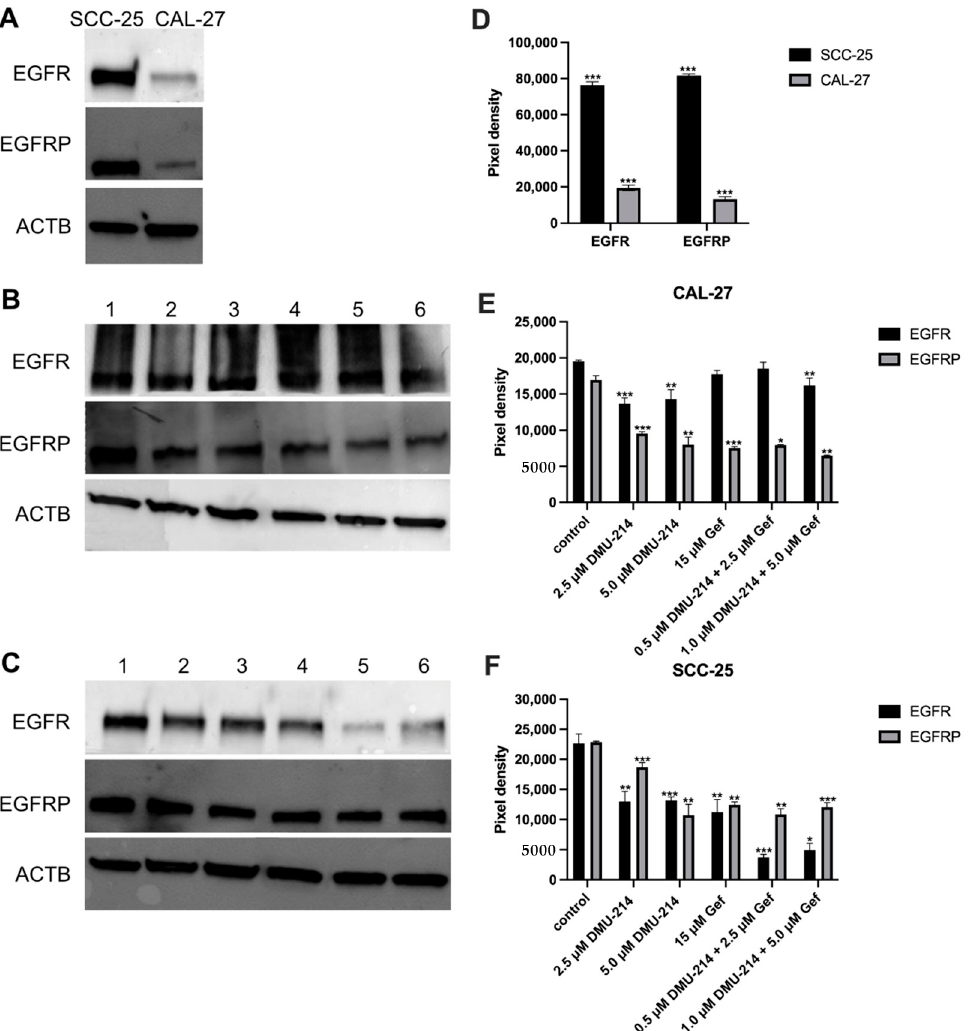
Figure 5. Western blot analysis of EGFR and EGFRP native expression pattern ( A ) as well as the effect of DMU-214, Gef, and the combination of DMU-214 and Gef on the EGFR and EGFRP ex- and the combination of DMU-214 and Gef on the EGFR and EGFRP expression profile in CAL-27 ( B ) and SCC-25 ( C ) cell pression profile in CAL-27 ( B ) and SCC-25 ( C ) cell lines. Cells were treated with: lane 1—control, lines. Cells were treated with: lane 1—control, lane 2—2.5 µ M DMU-214, lane 3—5 µ M DMU-214, lane 4—15 µ M Gef, control. Densitometric studies were used to analyze the level of EGFR and EGFRP in native expression pattern ( D ), as well as in CAL-27 ( E ) and SCC-25 ( F ) cells treated with a vehicle or DMU-214, Gef, and the combination of DMU-214 and Gef. Results of three independent replicates are presented as mean ± SD. *** p < 0.001, ** p < 0.01, * p < 0.05 indicate a significant difference from the